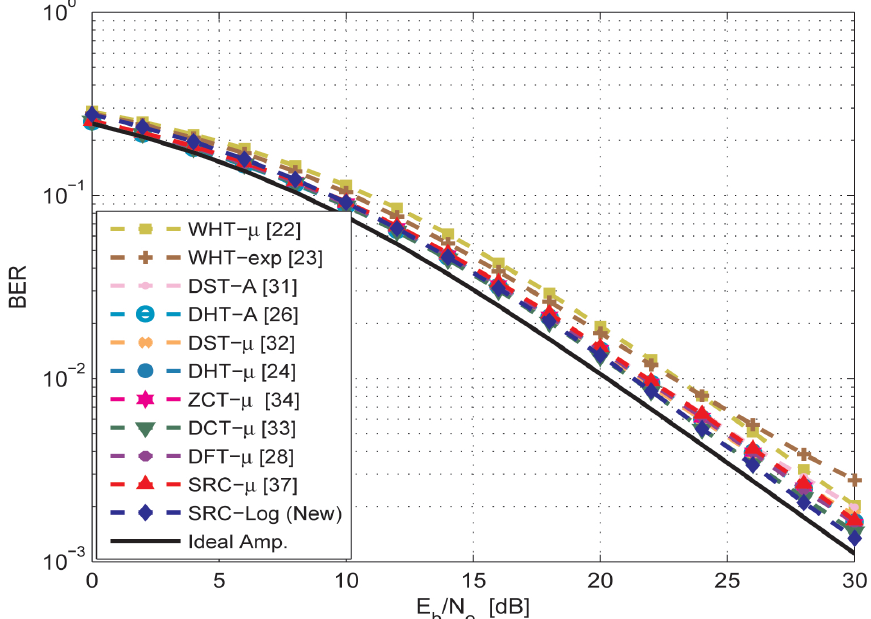
Figure 7. BER performance of the new SRC-Log techniques in Comparison with the previous precoding-companding techniques in the linear amplifier cases. In addition to the case of OFDM w/o PAPR reduction (solid